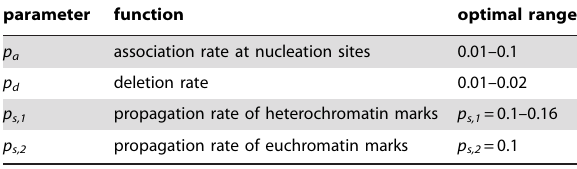
Table 1. Parameters of the computational model giving positive correlation with the experimental data on all simulated